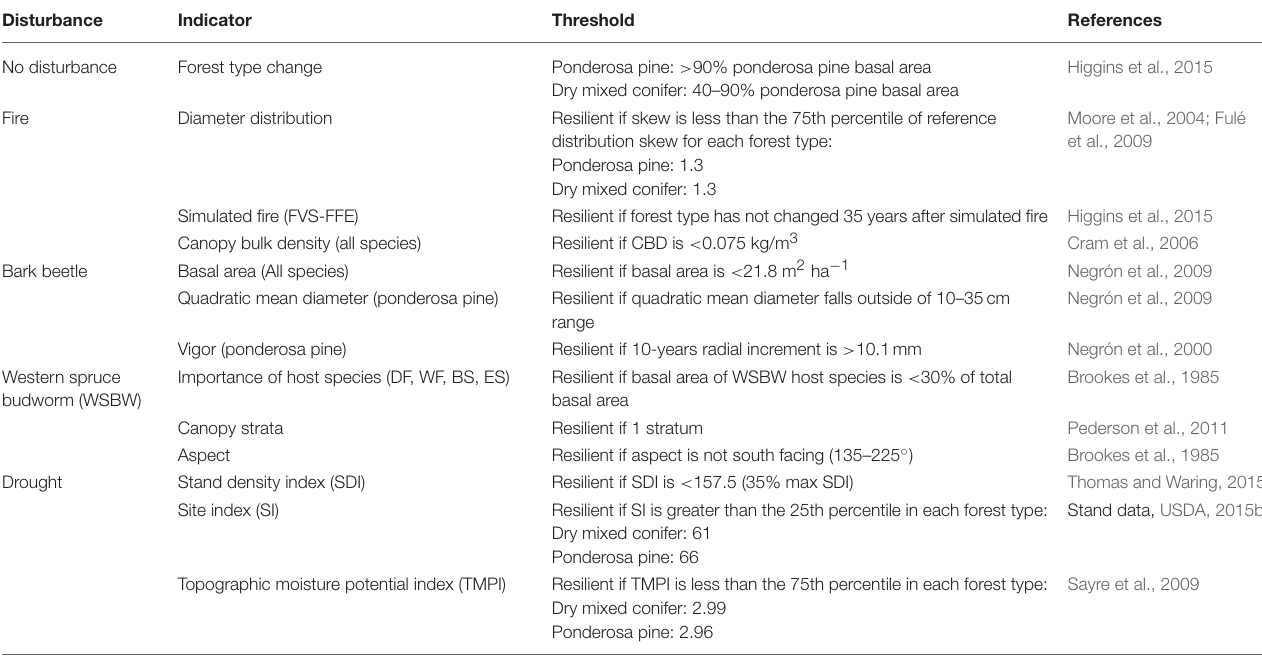
TABLE 1 | Indicators of potential resilience and thresholds for each of the four disturbance types.